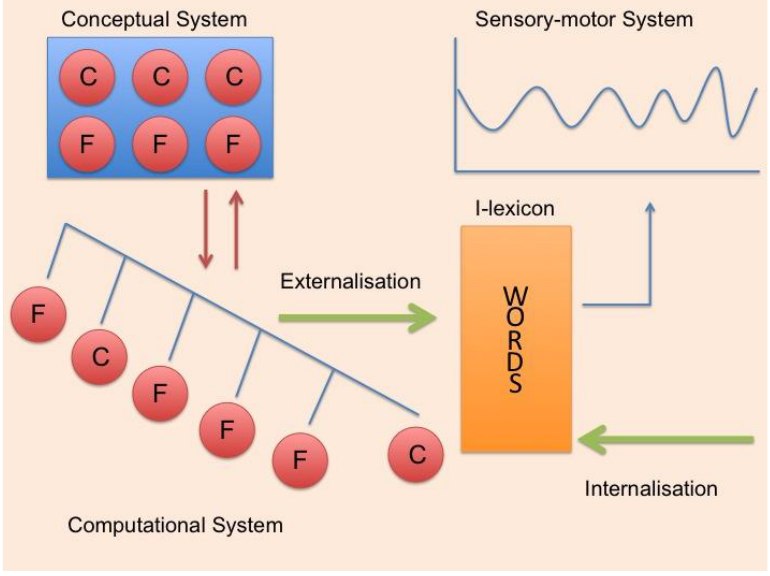
Figure 2: The anatomy of an I-language. The conceptual system and the computational system (as well as the sensory-motor system) are uniform across languages, while differences belong to the I-lexicon, which externalises syntactic